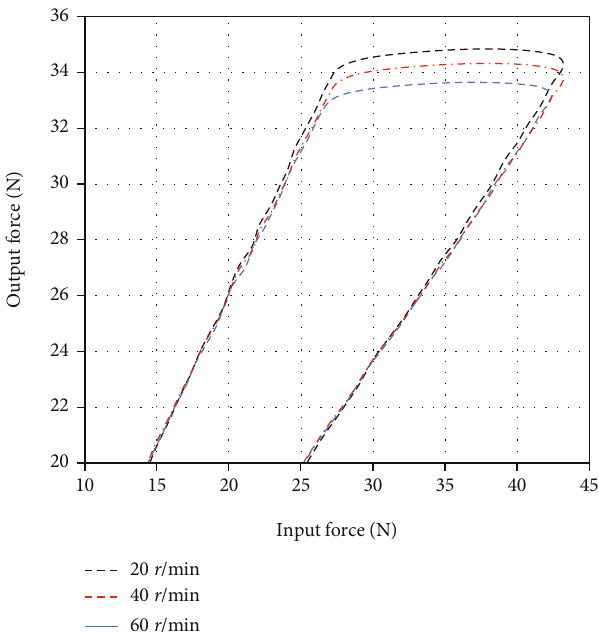
Figure 14: The variation of force transmission with various velocities of motor.